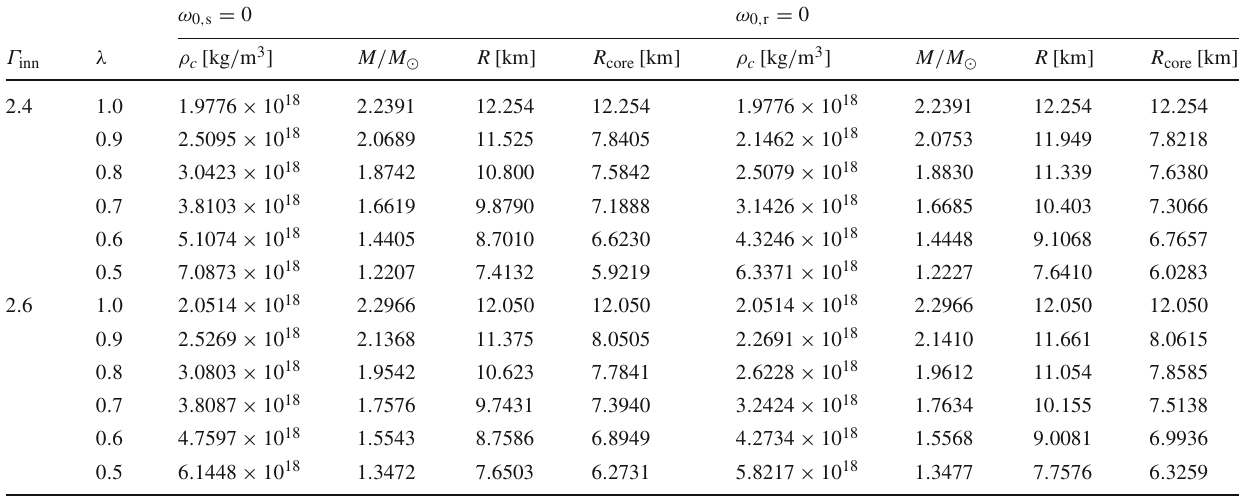
Table 1 The central energy density ρ c , the total mass M / M (cid:6) , the total radius R , and the core radius R core where the null eigenfrequency of oscillation of the slow case ω 0 , s and rapid case ω 0 , r are derived. These